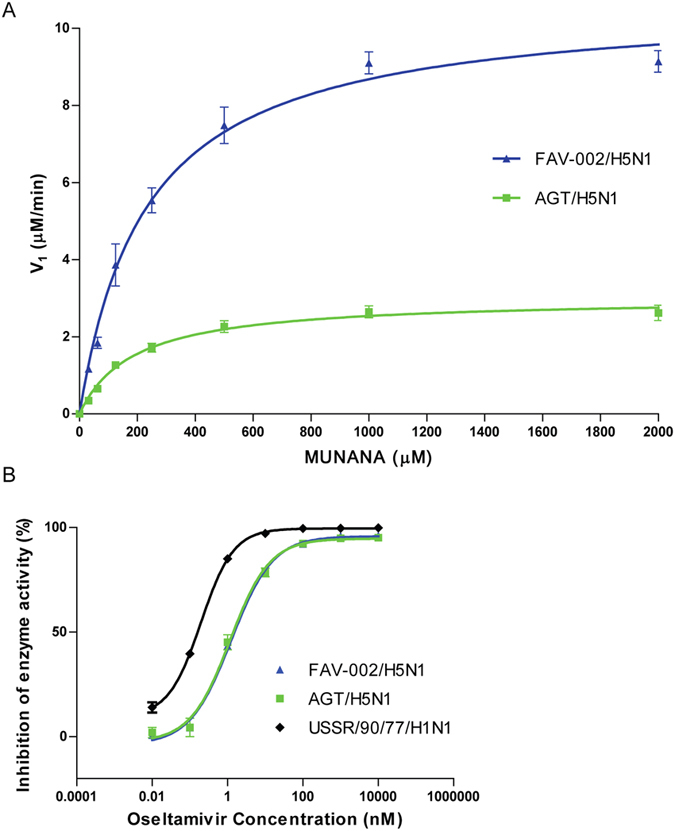
Neuraminidase enzyme kinetics and sensitivity of H5N1 viruses to oseltamivir.(A) Neuraminidase kinetic curves for FAV-002/H5N1 and AGT/H5N1. Relative fluorescent unit (RFU) values for each virus (FAV-002/H5N1 and AGT/H5N1) were plotted against a 2-fold dilution series of MUNANA to determine the maximum velocity (Vmax) and the binding affinity (Km) to MUNANA for each virus. (B) Comparative sensitivity to oseltamivir for each virus is reflected by the percent inhibition of enzyme activity at each concentration of oseltamivir carboxylate, plotted as the ratio of RFU at each dose over the RFU value with no drug treatment. P value < 0.0001.